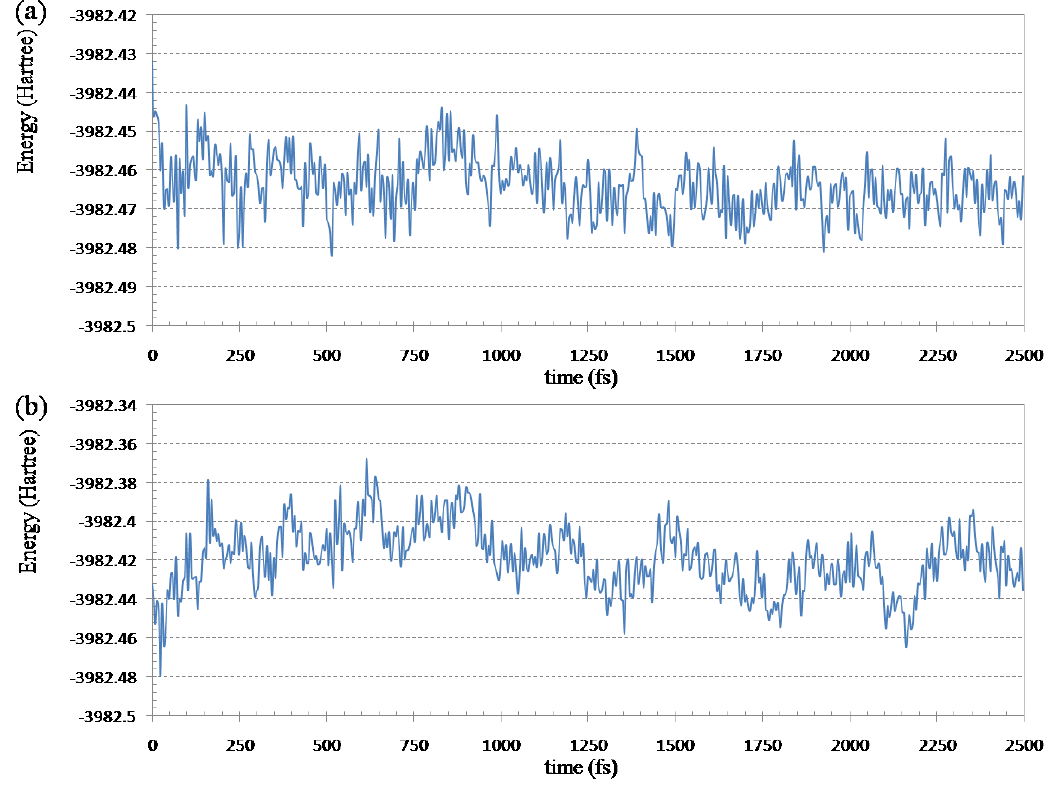
Figure 6. Fluctuations of the Hartree-Fock energy of (Gly) in the simulation at 298.15 K: ( a ) ELG-MD simulation; ( b ) conventional ab initio MD